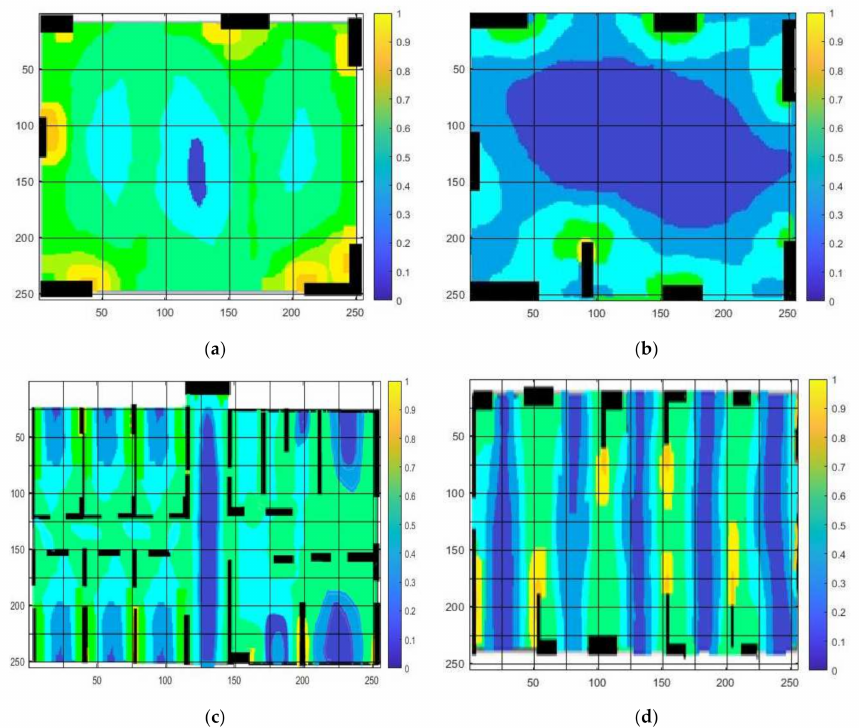
Figure 10. ( a ) Structural Model 1, ( b ) Structural Model 2, ( c ) Structural Model 3, and ( d ) Structural Model